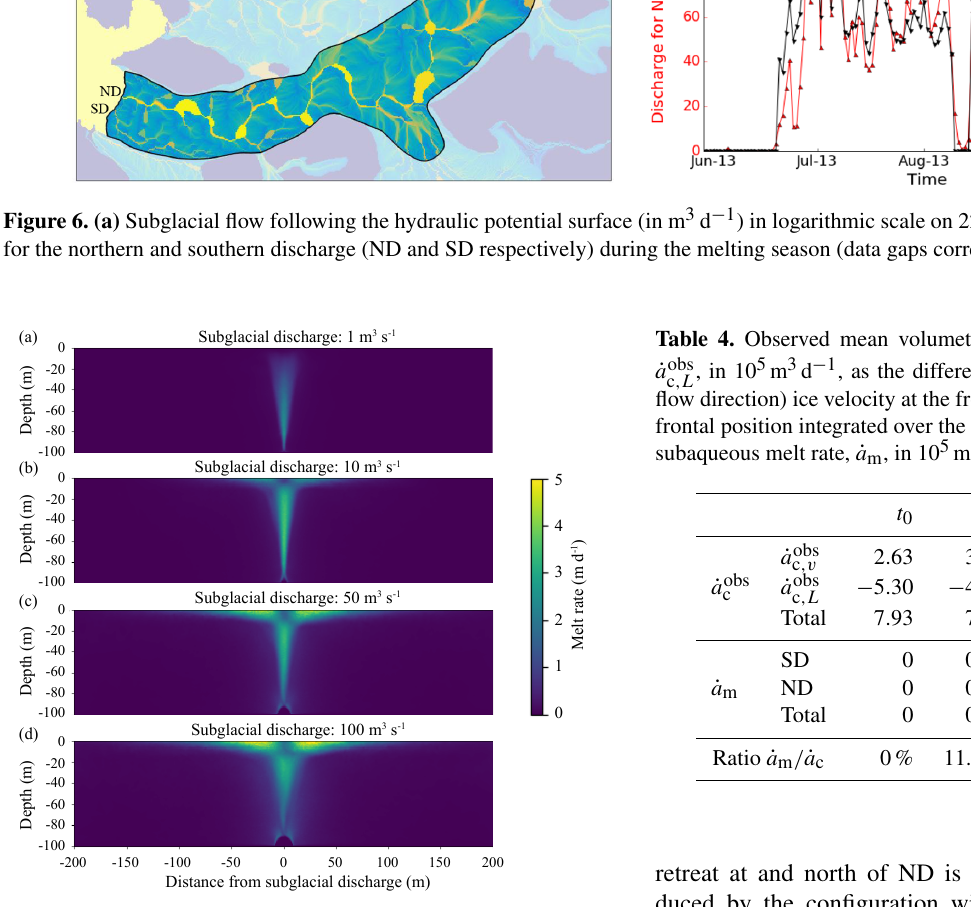
Figure 7. Melt rates, M d , from the plume model given a discharge, d , of (a) 1m 3 s − 1 , (b) 10m 3 s − 1 , (c) 50m 3 s − 1 and (d) 100m 3 s − 1 .